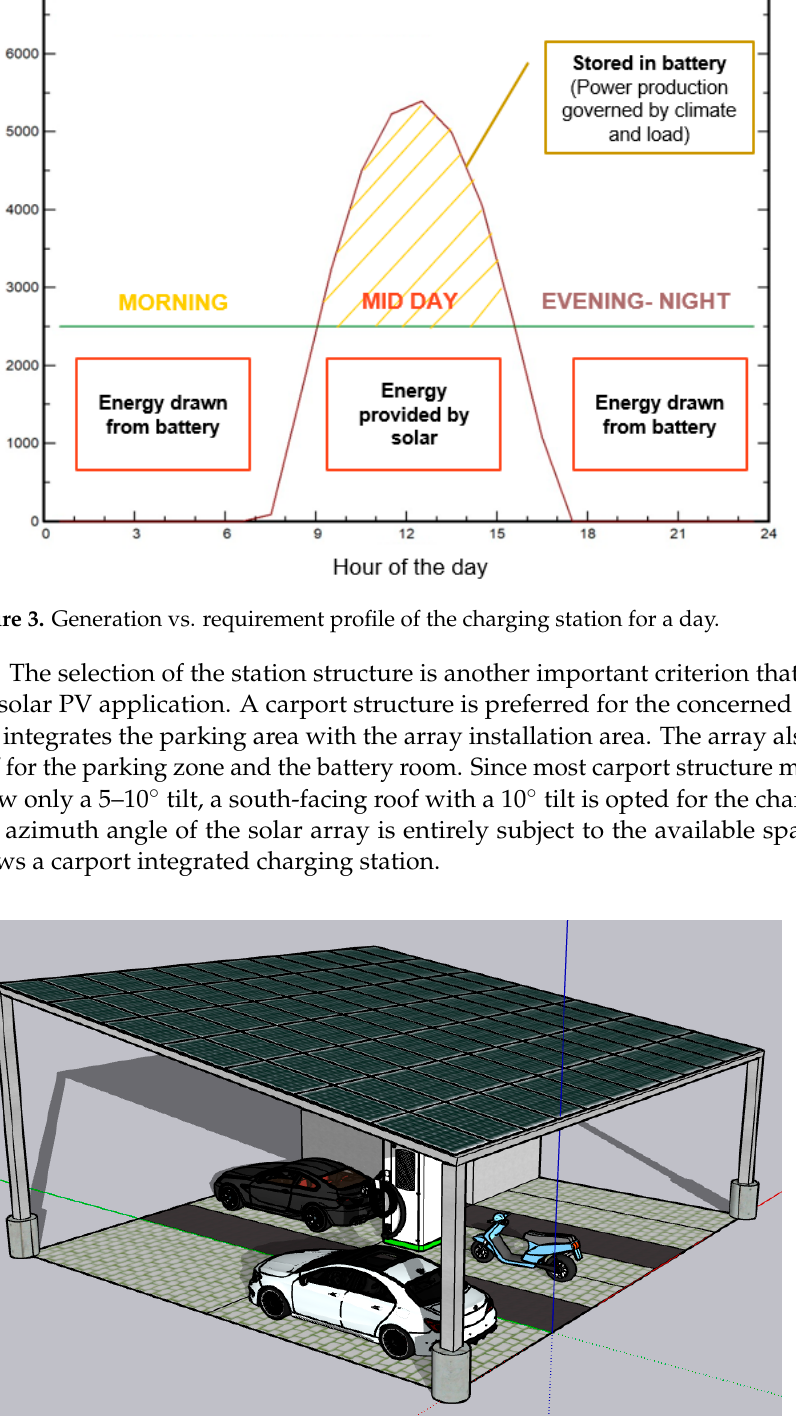
Figure 4. Schematic representation of carport charging infrastructure .